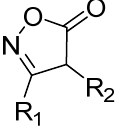
Figure 1. Isoxazol ‐ 5(4H) ‐ ones. Figure 1. Isoxazol-5(4H)-ones.